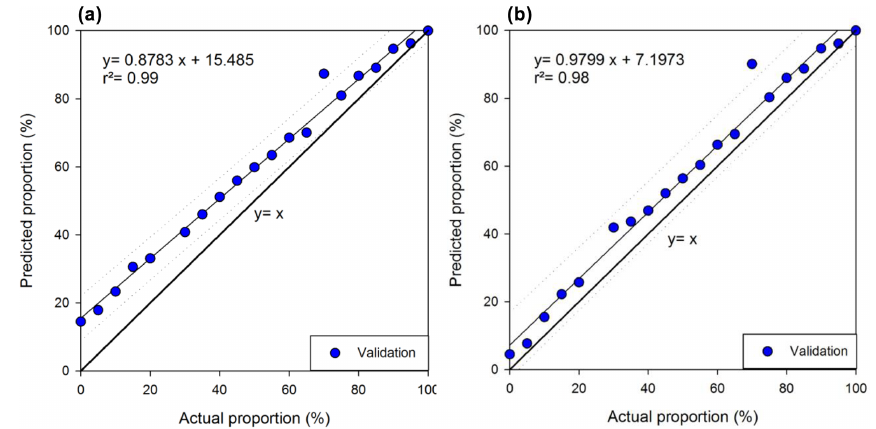
Figure 5. Comparison between actual mining source proportions prepared in artificial mixtures and the mining source proportions predicted by the geochemistry (a) and colour + geochemistry (b)